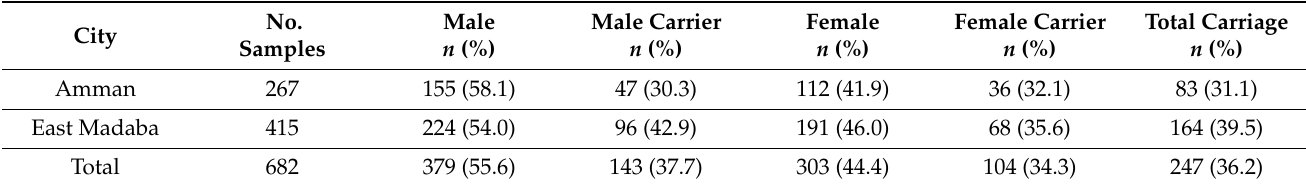
Table 1. Source of NP samples according to the gender and total carriage,